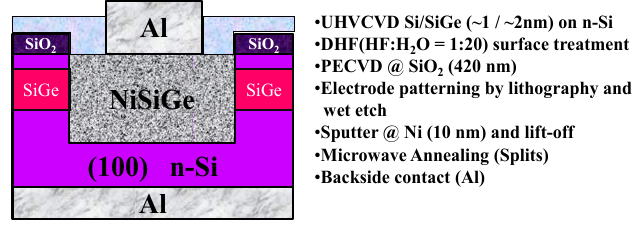
Figure 1. Schematic diagram and process flow of fabricating the NiSiGe/n ‐ Si Schottky junction structure.